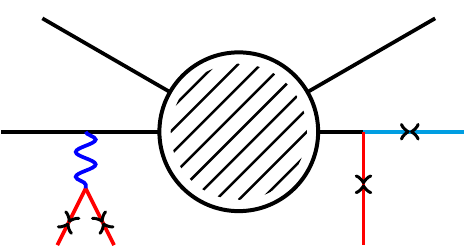
Figure 19 . Feynman diagram for three soft gravitini | IV.